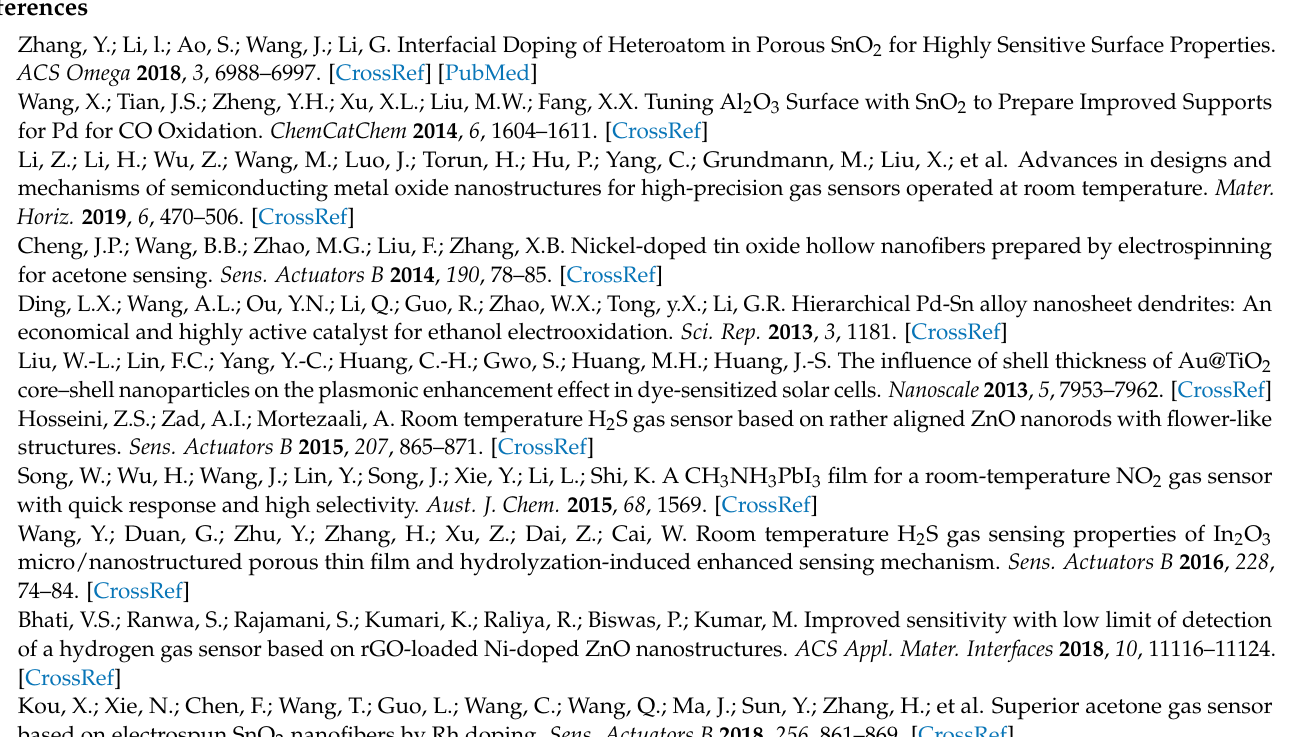
(b) sample C2 (low magnification image including area presented in Figure 7c), Table S1: Results of the EDX analysis of the samples, Table S2: Indexed Lattice Planes from the SAED pattern presented in Figure 6f, Table S3: Indexed Lattice Planes from the SAED pattern registered for sample